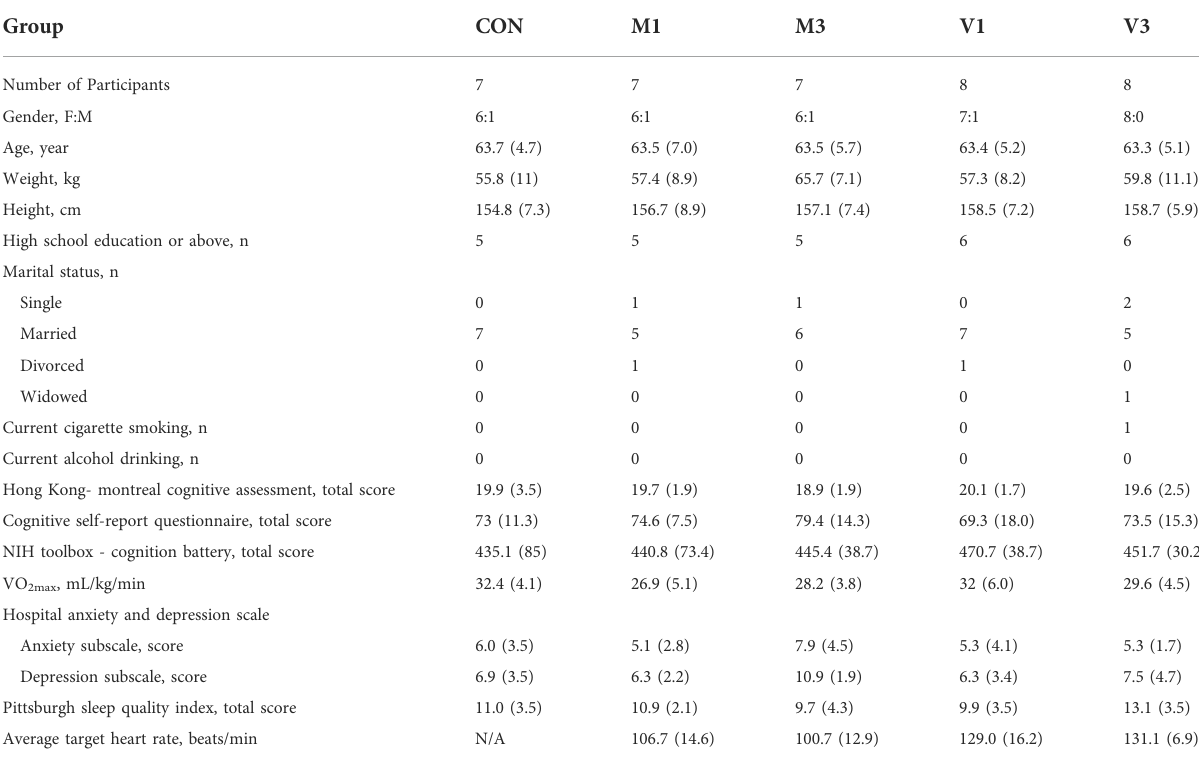
TABLE 1 Baseline characteristics of participants.